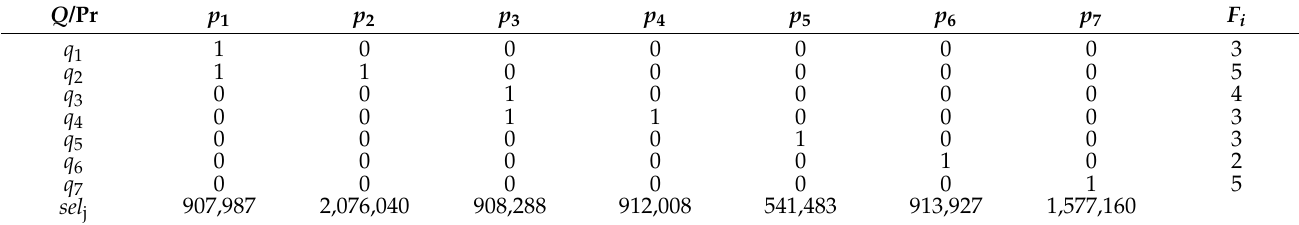
Table 5. Predicate Usage Matrix for the scenario.